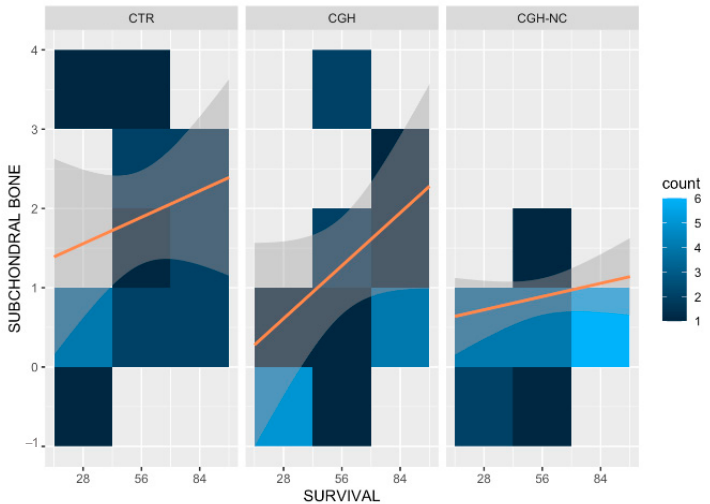
Figure 5. Heat map representing “subchondral bone” changes in the different treatment groups at different survival times and the frequency of occurrence at different survival times. Clearer colours result in an increase of the frequency of each stage of the disease. Orange lines are included on the maps to facilitate the understanding of the behavior of each treatment and the survival time. A statistically significant change occurred in all groups regardless of the treatment ( p <